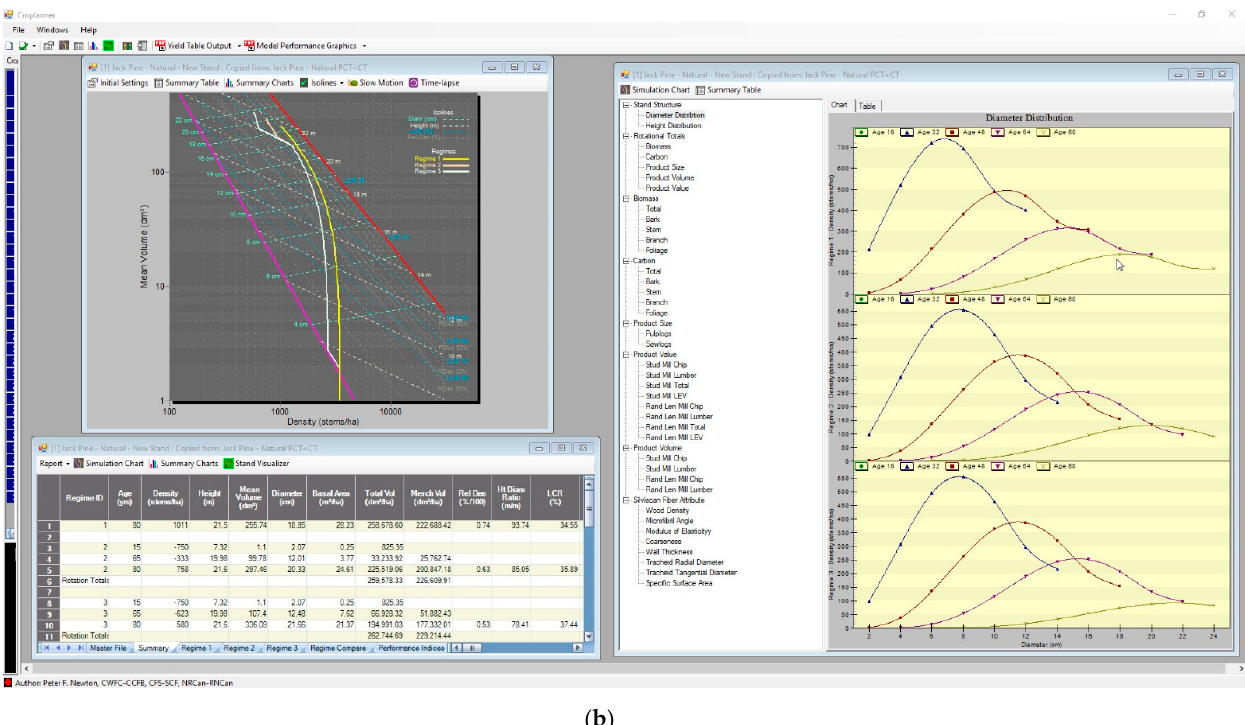
Figure 2. ( a ) Exemplification of the generic input GUI dialog structure of the CP DSS when used to simulate 3 potential crop plans for natural-origin jack pine stands established at high densities (3500 stems/ha) on medium-to-good site qualities (site index 18 [65]). In this example, Regimes 1, 2 and 3 denote the 3 specific crop plans simulated over an 80 year rotation length: (1) unthinned control stand (Regime 1); (2) thinned stand consisting of a PCT treatment implemented at an age of 15 yr in which 750 stems/ha were removed followed by a CT treatment at an age of 65 yr in which 15% of the basal area was removed (Regime 2); and (3) thinned stand consisting of a PCT treatment implemented at an age of 15 yr in which 750 stems/ha were removed followed by a CT treatment at an age of 65 yr in which 30% of the basal area was removed (Regime 3). As shown, the required input included the operability criteria, economic parameters, model defaults in terms of merchantability specifications, and regime-specific details regarding initial density, rotation age, operational adjustment and product degrade factors, variable cost estimates at harvest and the magnitude of the thinning response expected. For each thinning treatment, the age of intervention, type (PCT or CT), intensity (number of trees or basal area removed) and cost estimates, are also specified. ( b ) Exemplification of an abridge selection of graphic and tabular outputs derived from the CP DSS when used to simulate the 3 potential crop plans as defined in ( a ). As shown, the resultant crop plans are presented within traditional SDMD graphic (upper left-hand side) along with abridge tabular yield summaries for each crop plan (lower left-hand side), illustration of the graphical reporting options (right-hand side) with the specific presentation of the temporal diameter frequency distributions for each crop plan throughout the rotation (right-hand side). Note, abbreviations Vol, Merch, Rel Den, Ht Diam and LCR refer to volume, merchantable, relative density, height and diameter, and live crown ratio, respectively. Refer to Summary Report SM1 (Supplementary Material) for a complete account of the output produced for this crop plan set.